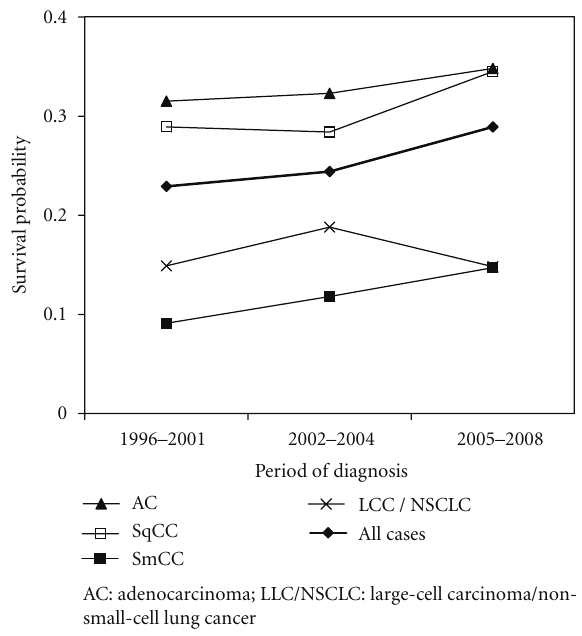
Figure 4: Trend in two-year overall survival by lung cancer histotypes: Ticino, incident cases in the periods 1996–2001, 2002– 2004, and